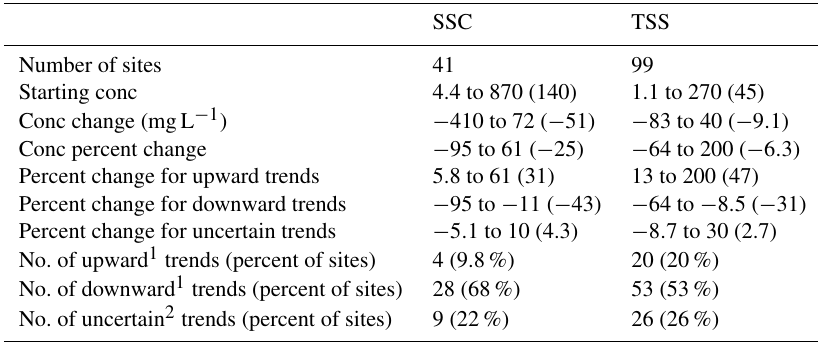
Table 2. SSC and TSS trends from 1992 to 2012. Rows for starting concentration, concentration change and percent change show minimum – maximum (mean) rounded to two significant figures (SSC, suspended-sediment concentration; TSS, total suspended-solid concentration; no., number; conc, concentration; mgL − 1 , milligrams per